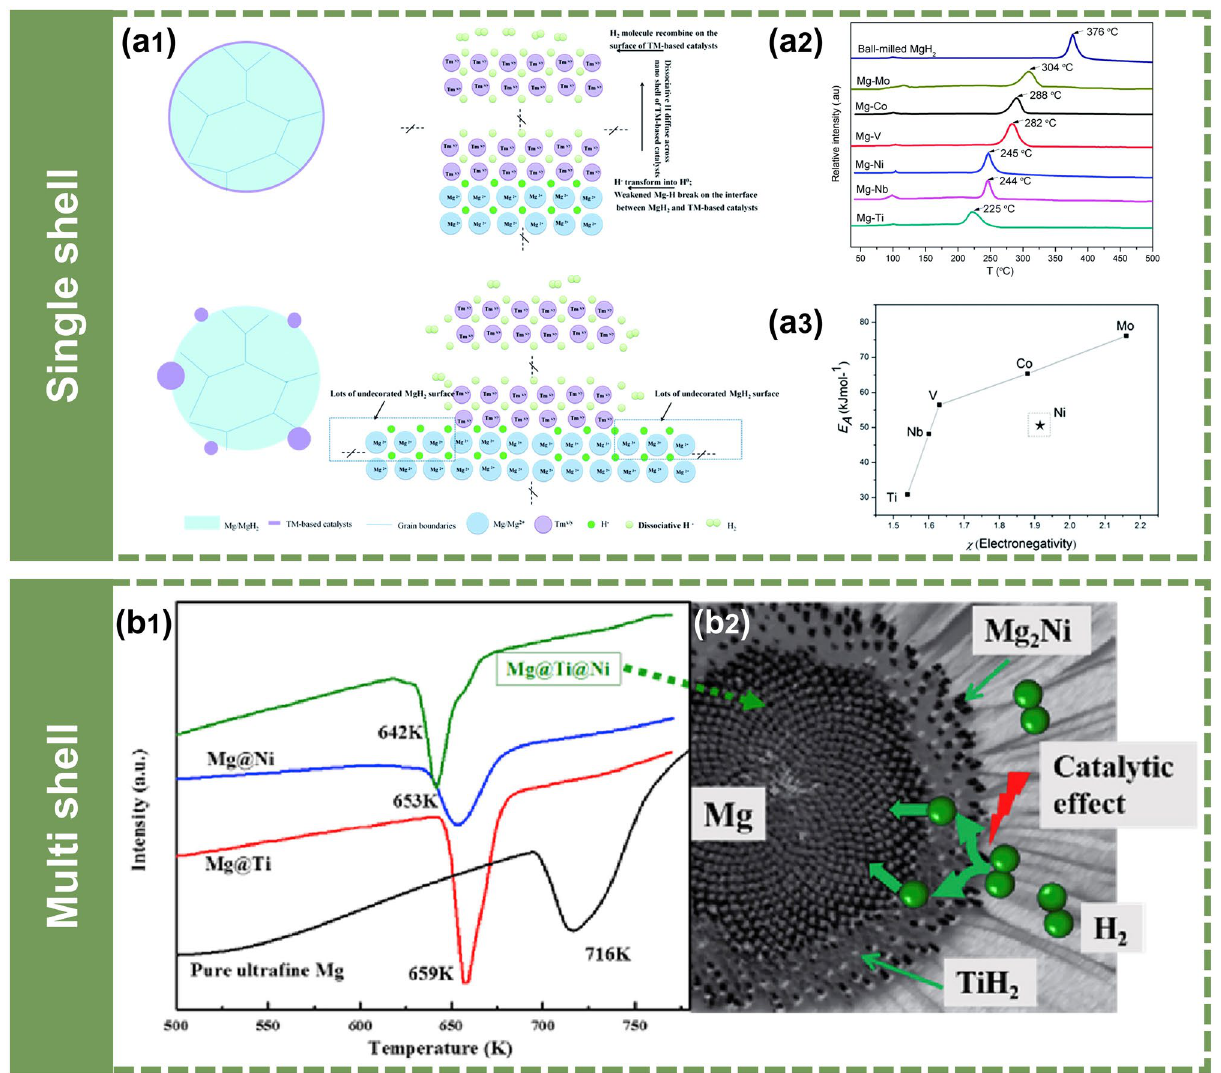
Fig. 8 Synthesis of core–shell nanostructured Mg-based composites through chemical reduction. a1 A schematic diagram of the Mg–TM and ball-milled Mg–TM-based catalysts. a2 TPD-MS curves of Mg–TM samples with a heating rate of 4 K min −1 . a3 Plot of E A verses χ of TM in Mg–TM systems. Reproduced with permission from Ref. [107]. Copyright 2014 Royal Society of Chemistry; b1 DSC curves of different samples. b2 A schematic diagram of Mg@Ti@Ni composite with core–shell structure. Reproduced with permission from Ref. [109]. Copyright 2017